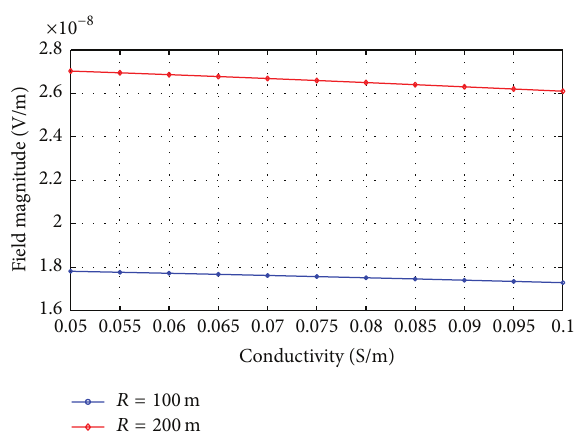
Figure 13: Current distribution on the antenna surface by HFSS.